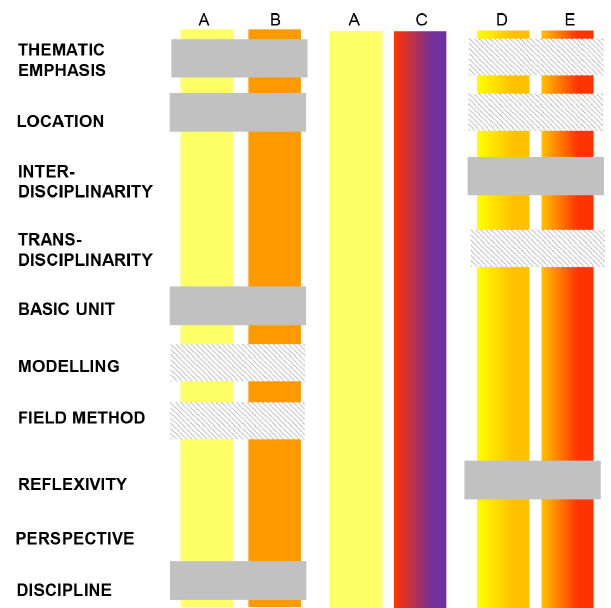
Figure 4. Graphical representation of potential mental model over- laps between pairs of stylised types of connectivity scientists. Stylised types of connectivity scientists (Fig. 3) after Öberg (2011) are represented here by pragmatic (yellow, A) and conceptual (or- ange, B). Remaining mental models (from group of 13 scientists) were classified as mixed types according to perspective: (C) be- tween epistemological (red) and ontological (violet), (D) pragmatic and conceptual, and (E) conceptual and epistemological. Grey bars show overlap, and shaded grey bars show partial overlap. There can be considerable overlap between the pragmatic (A) and the con- ceptual (B) perspectives. There is no potential overlap between the pragmatic and the ontological perspectives. Several overlaps oc- curred between mixed types (D and E), but those differed from A– B overlaps. We elicited some overlap between the epistemological and the ontological perspectives, but the number of individuals con- sulted here was too small to draw any